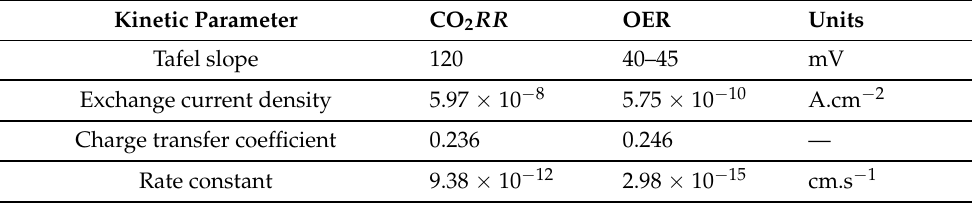
Table 1. Kinetic parameters for the CO 2 RR and the oxygen evolution reaction taken from Refs. [42,43] Kinetic Parameter CO 2 RR OER Units Tafel slope 120 40–45 mV Exchange current density 5.97 × 10 − 8 Charge transfer coefficient 0.236 0.246 — Rate constant 9.38 × 10 −